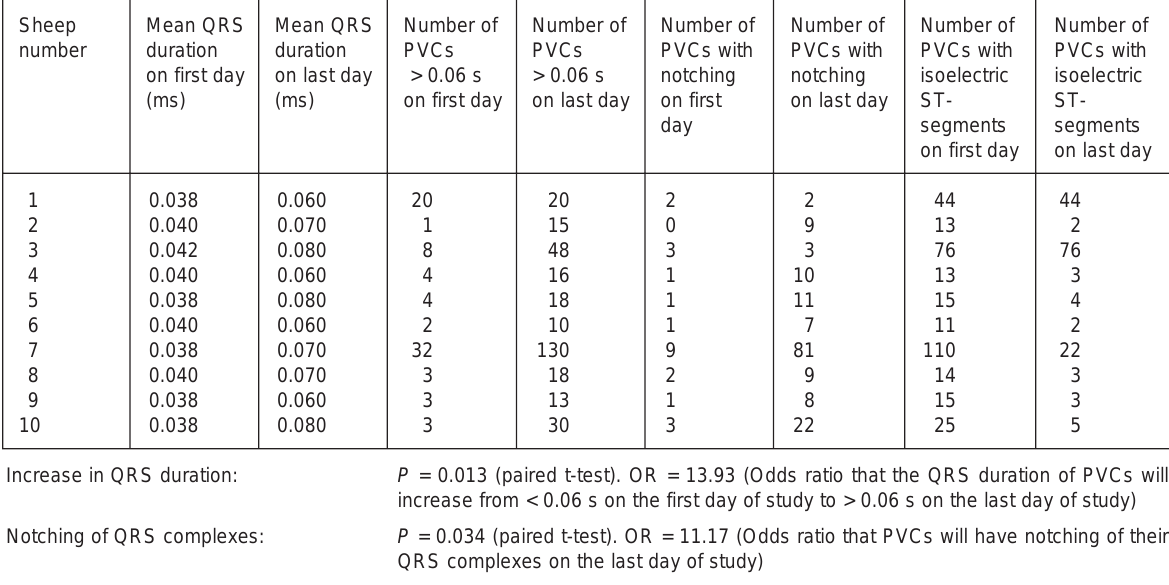
TABLE 1 Electrocardiographic characteristics of PVCs on the first and last day of study Sheep Mean QRS Mean QRS Number of duration